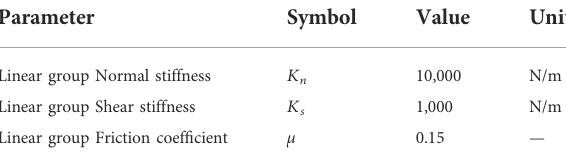
FIGURE 5 Geometric model.